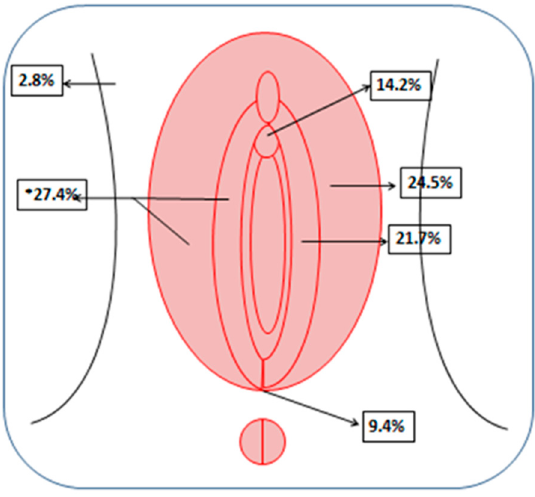
Figure 1. Topographic distribution of the treated lesions.